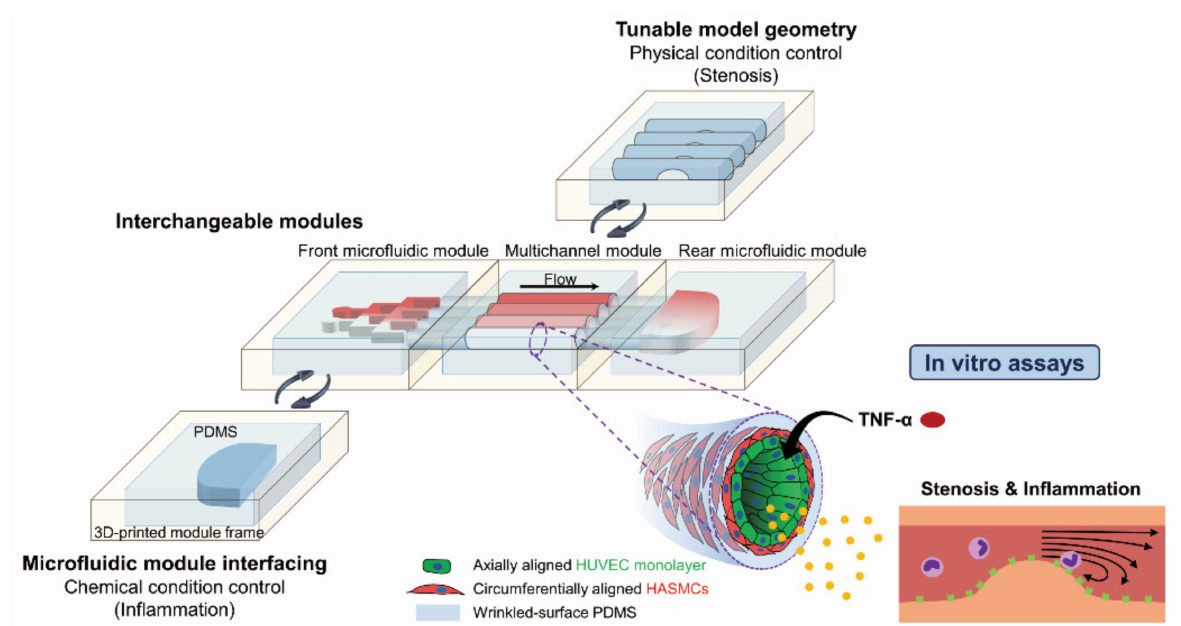
Figure 1. An artery-mimicking multichannel modular device for in vitro disease models. Each module, consisting of a three-dimensionally printed module frame and polydimethylsiloxane (PDMS), can be replaced, depending on the analytical purpose. The interchangeable microfluidic module interfacing enables parallel coculture model fabrication in the multichannel and chemical condition control. An in vitro artery-mimicking multichannel module with tunable model geometries for stenosis is also interchanged and used. In each channel of the in vitro artery module, axially aligned confluent human umbilical vein endothelial cell (HUVEC) monolayers and circumferentially aligned and stretched human aortic smooth muscle cells (HASMCs) are cocultured on a wrinkled surface. A modular 3D in vitro multichannel system that mimics the human artery can be used for in vitro assays to demonstrate vascular stenosis and